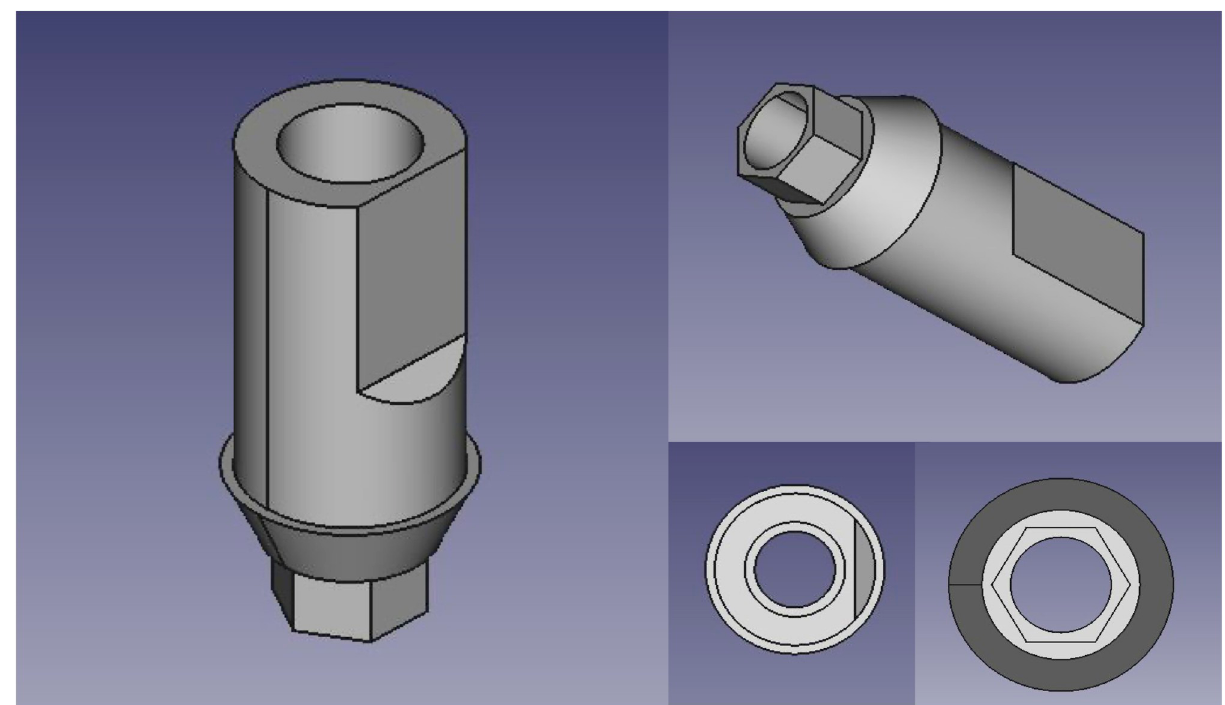
Fig 1. Scan body design.